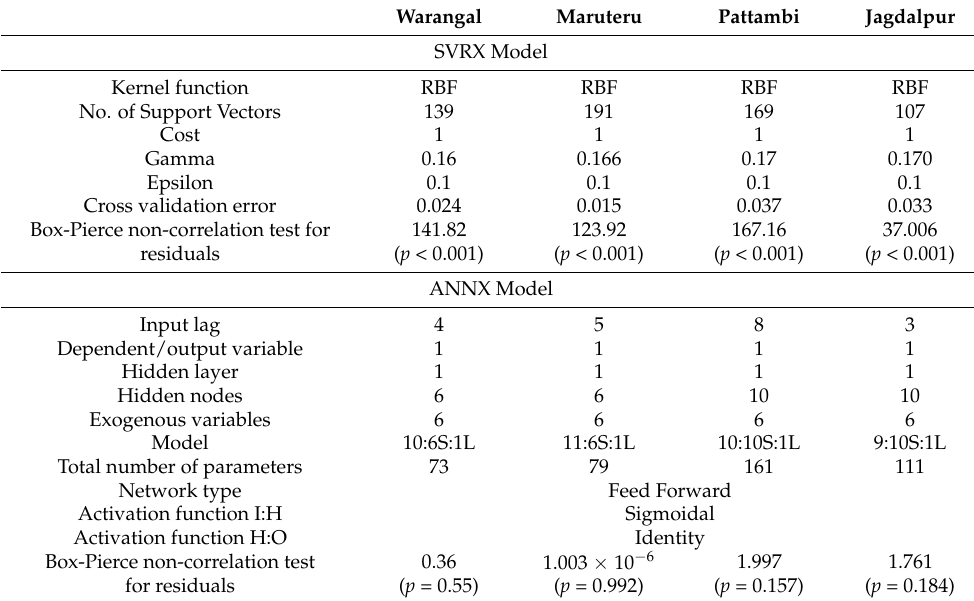
Table 5. Parameter specifications of SVRX and ANNX models for gall midge populations at study locations.